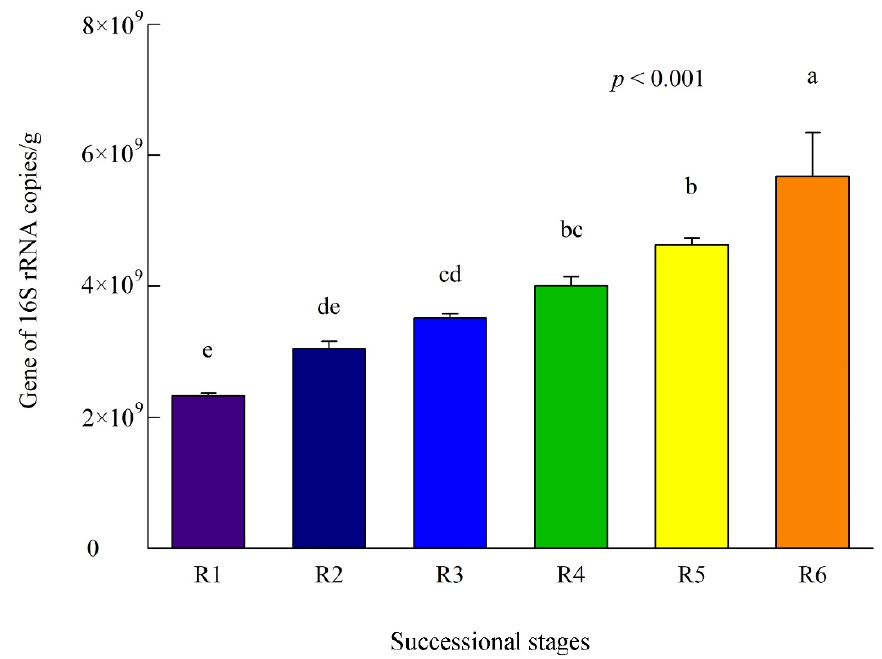
Figure 2. Total bacterial abundance was indicated by the 16S rRNA copies per gram of soil (mean ± SE, n = 4) (0–20 cm depth) of different successional stages on the Loess Plateau of China. Different lower-case letters indicate statistically significant differences at the α = 0.05 level between successional stages. R1: Farmland control; R2: Pioneer weeds; R3: Herbage ( M. sacchariflorus ); R4: Shrub ( H. rhamnoides ); R5: Early forest ( P. davidiana ); and R6: Climax forest ( Q. mongolica ). The bacterial OTU richness was greatest in the farmland stage (Table 1). Species